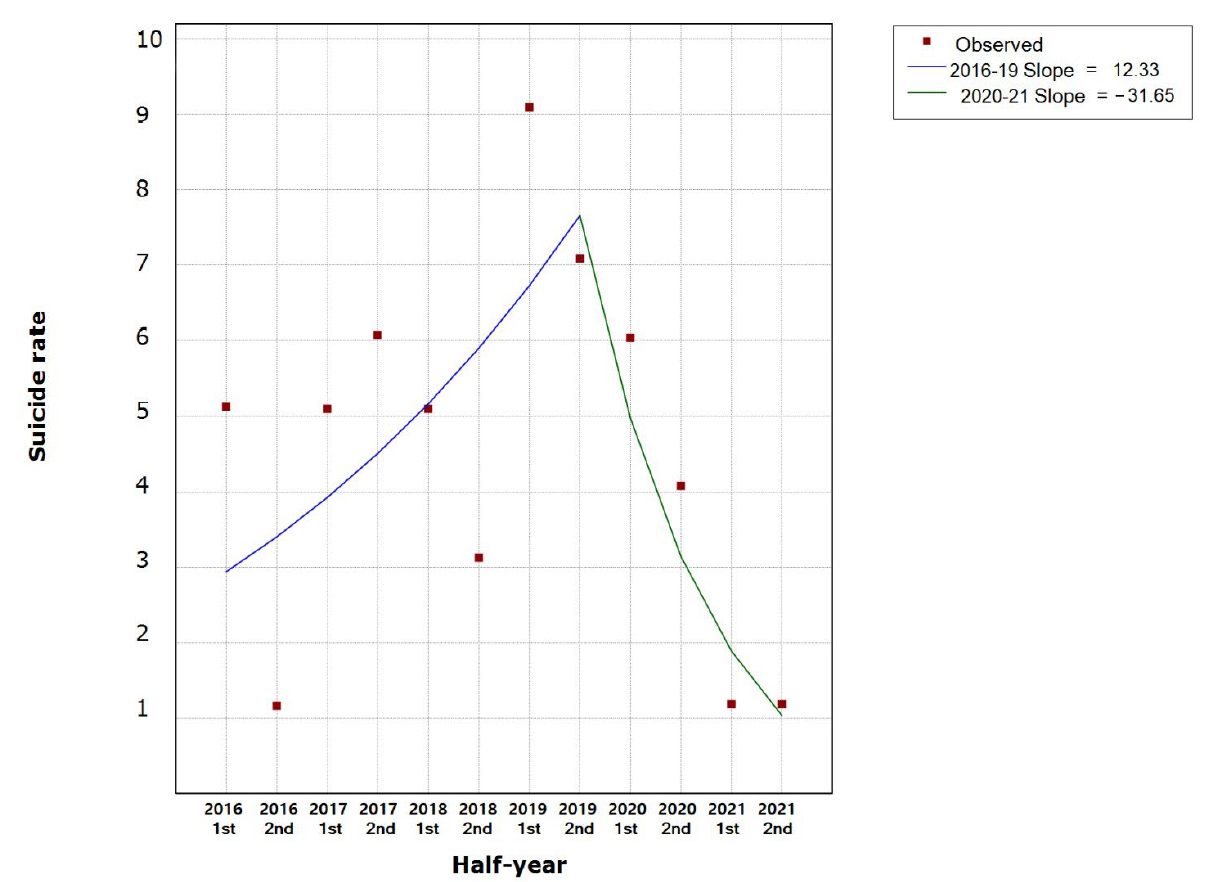
Figure 1. The trend of suicide rate (per 100,000 population) during the study period.